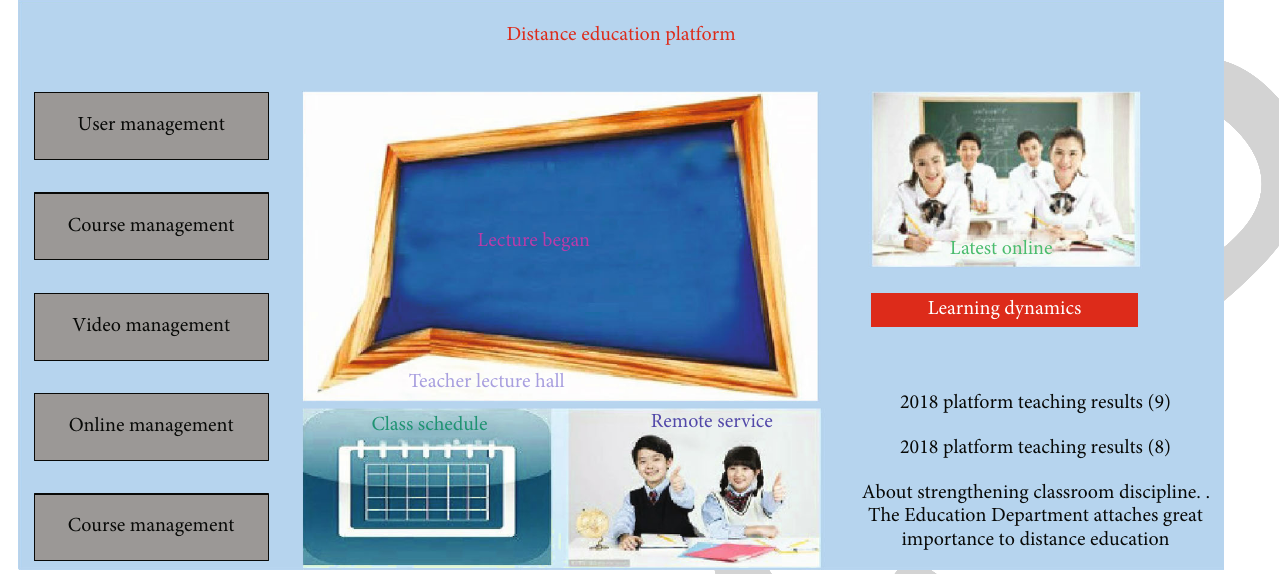
Figure 5: The main interface of the distance education